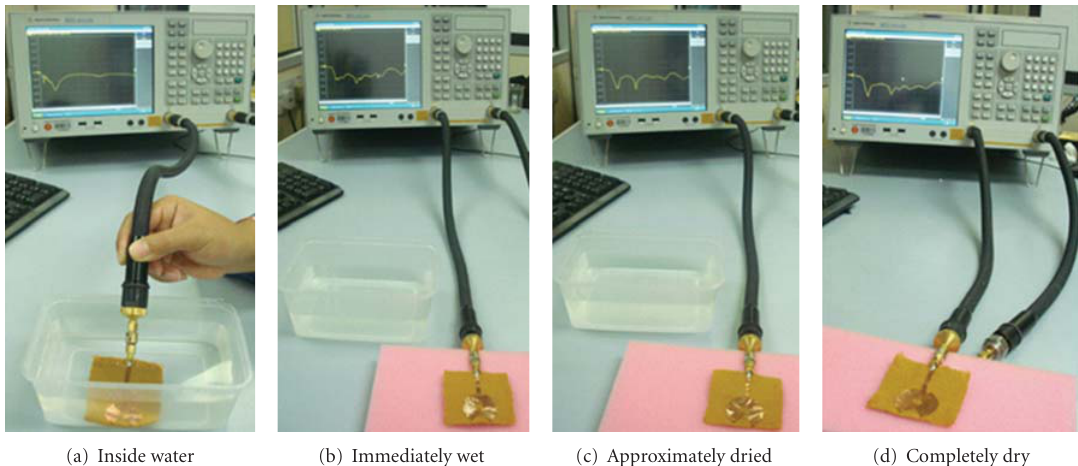
Figure 12: Snapshots of measured results of UWB antenna prototype using copper conducting sheet considering di ff erent states of wetness, dampness, and fully dried.